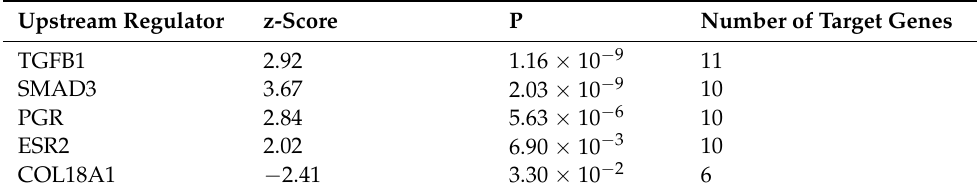
Table 3. Upstream regulator analysis of the 618 mRNAs that were differentially expressed (corrected p < 0.01) between POP and non-POP tissues in 12 POP patients (see Materials and Methods). The 5 upstream regulators that are present in the POP landscape are listed with a z-score ≥ 2.00 or ≤ − 2.00, indicating that they are predicted to be activated or inhibited, respectively. For each regulator, the p -value—referring to how enriched the targets of each upstream regulator are in the differentially expressed mRNAs—and the number of target genes are also listed.